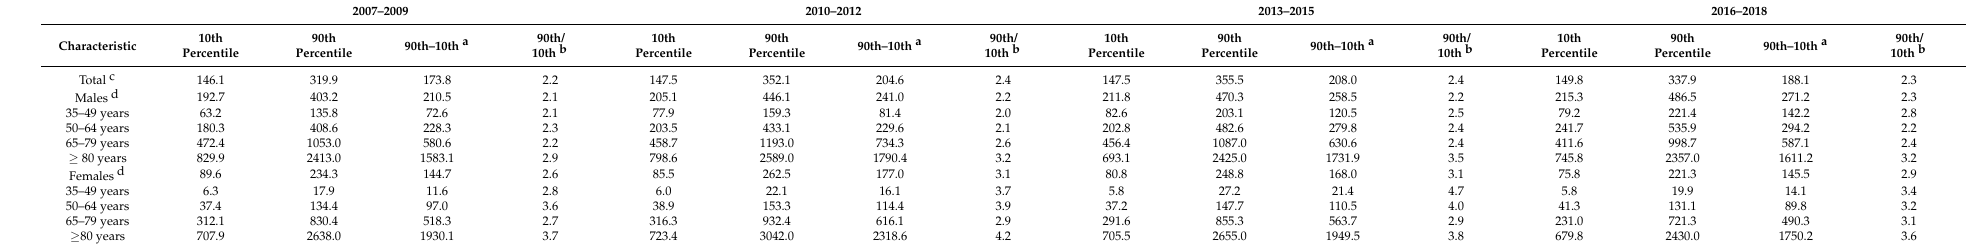
Table 2. Inequalities in the Incidence of Acute Myocardial Infarction by Township, 2007–2018 (per 100,000